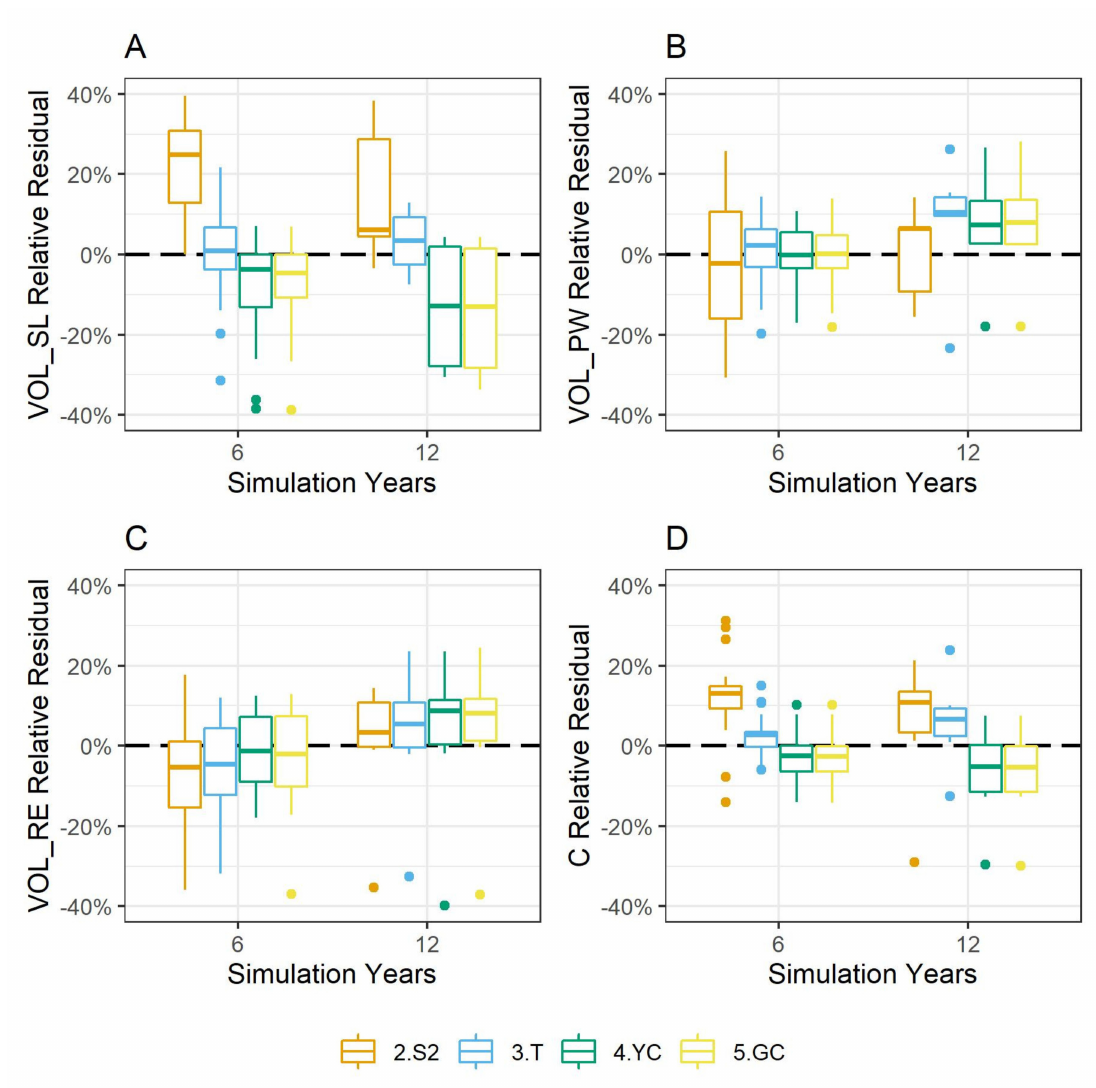
Figure 3. Ecosystem services for simulation S2, T, YC, and GC, see text for definitions. ( A ): saw-log volume (VOLP_SL, m 3 ha − 1 ), ( B ): pulpwood volume (VOLP_PW, m 3 ha − 1 ), ( C ): residual volume (VOLP_RES, m 3 ha − 1 ), and ( D ): carbon stock (C, tonnes C ha − 1 ). Statistics are presented as box plots of relative residuals at 6 and 12 years of projection in second-growth RORACO forests in southern